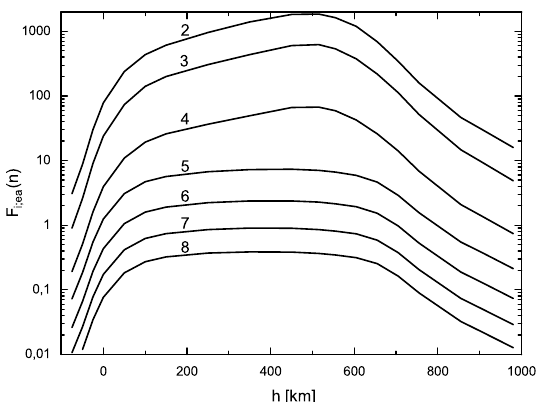
Fig. 1. Behavior of the quantity F ( ab )